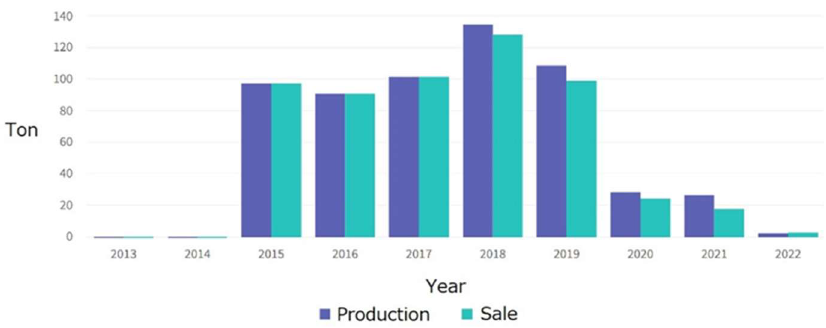
Figure 3. Gold production in Indonesia (Source: Ministry of Energy and Mineral Resources).